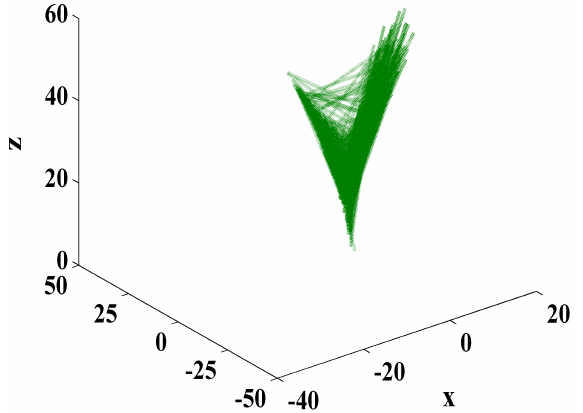
Figure 3. Three-dimensional reconstructed attractor of Lorenz’s hyperchaos mapping system in the ( x , y , z )-plane.